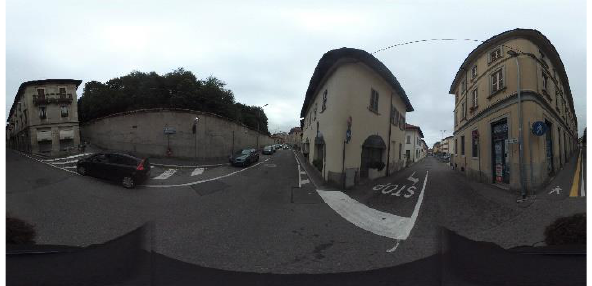
Figure 3. On demand panoramic image obtained by pressing the dedicated button on the touchscreen control unit. Resolution: 5640x2820